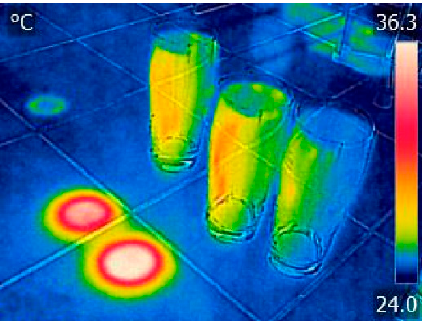
Figure 2. Infrared thermographic recordings of glasses.